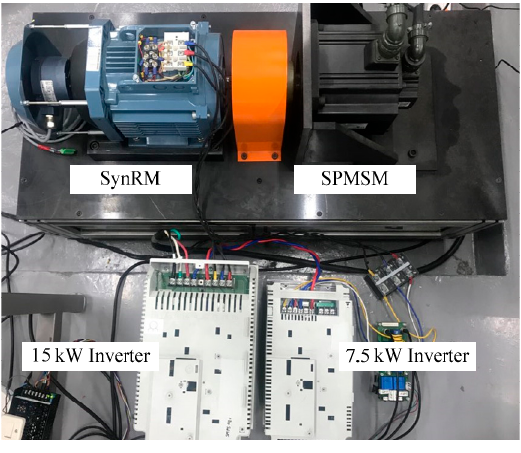
Figure 6. Experimental test setup. Table 1. Nominal parameters of the 3 kW SynRM.